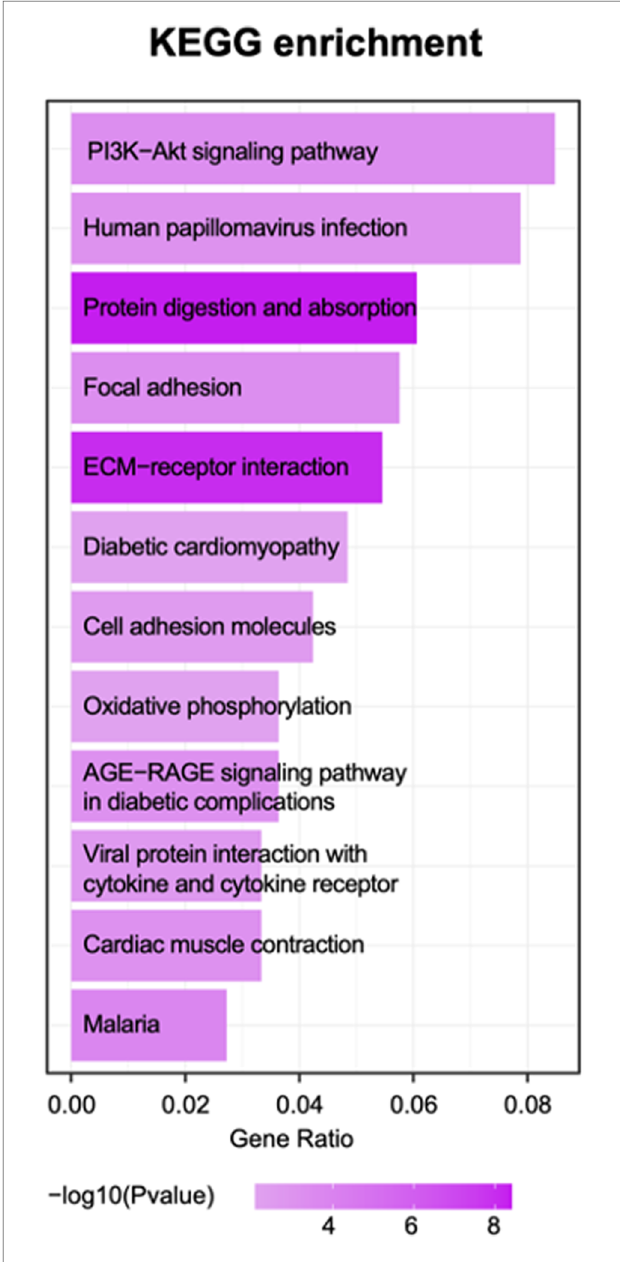
FIGURE 4 The top 10 enrichment KEGG pathway